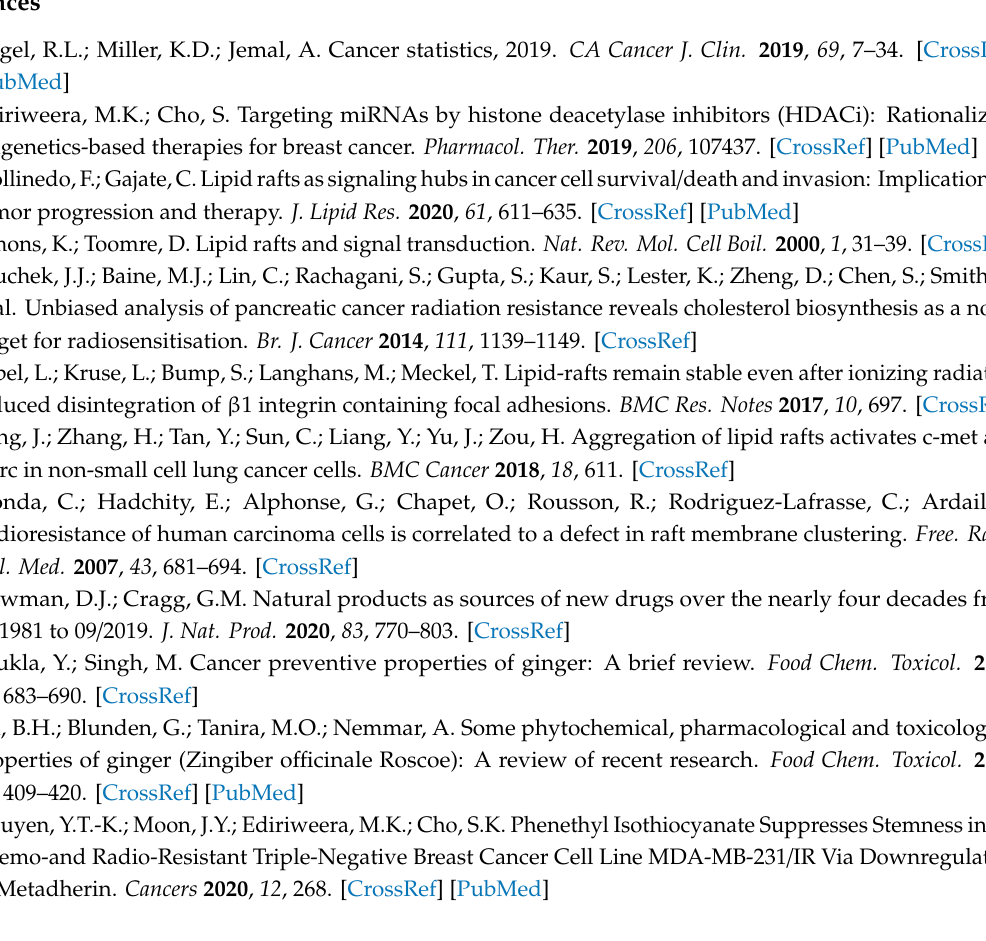
Figure S1: E ff ects of 10-gingerol on MDA-MB-231 cell viability, Figure S2: Lipophilicity prediction of 10-gingerol using the SwissADME webserver, Figure S3: E ff ects of 10-gingerol on the total expression of caveolin-1 in MDA-MB-231 / IR cells, Figure S4: Comparison of lipid rafts cholesterol levels in MDA-MB-231 and MDA-MB-231 / IR